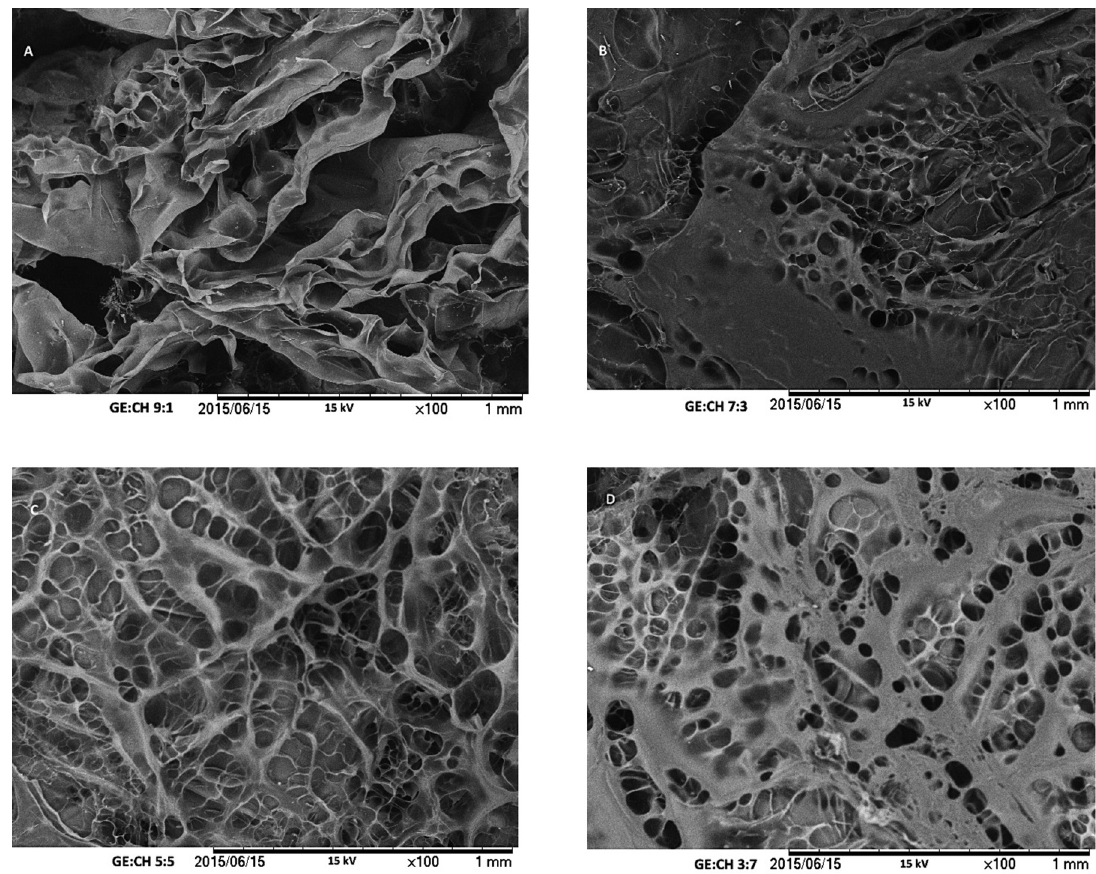
Figure 3: Superficial SEM Images of scaffolds obtained with different GE:CH ratios: 9:1 (A), 7:3 (B), 5:5 (C) and 3:7 (D). results indicated that freezing processing had an